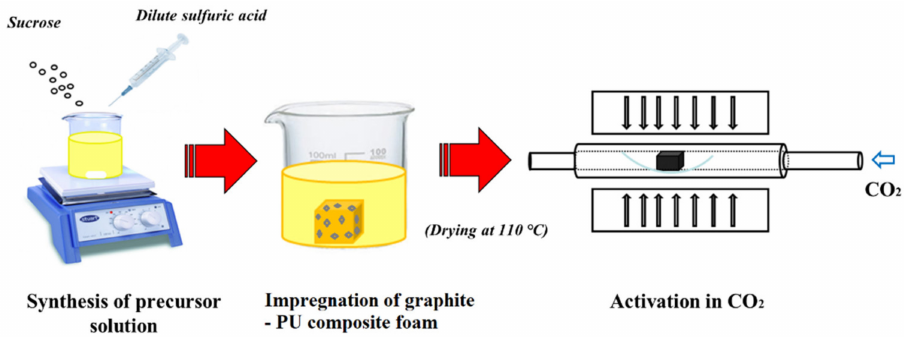
Figure 1. Flow diagram for the synthesis of composite activated carbon